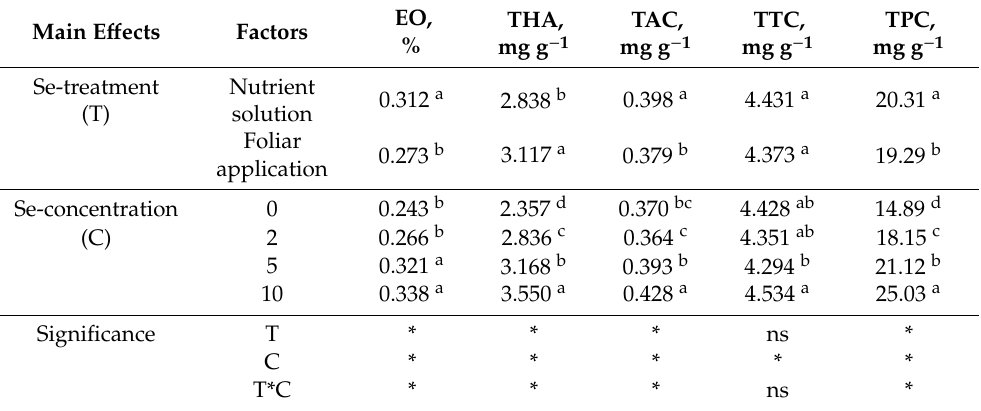
Table A2. Results of 2-factorial ANOVA for essential oils and the phenolic compound content in basil leaves under Se application.